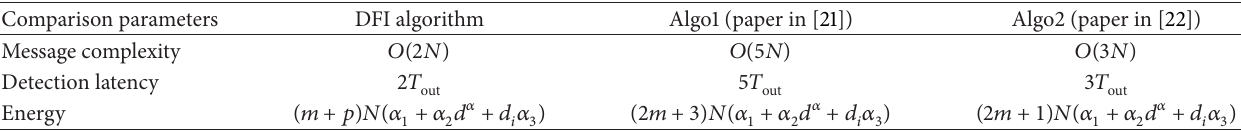
Table 1: Comparison study on existing method with proposed